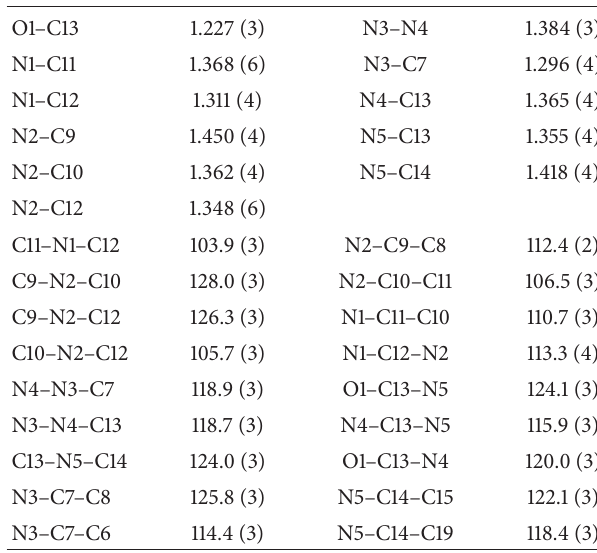
Table 2: Selected geometric parameters (˚A, ∘ ).